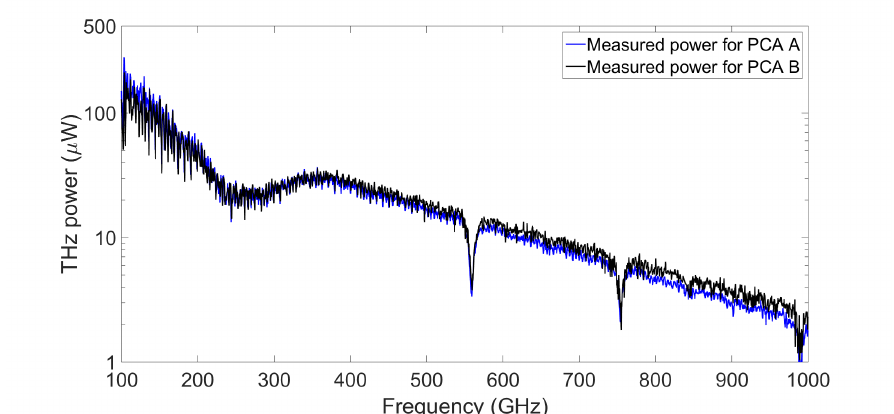
Figure A1. Measured THz powers emitted by the pin diode for the characterization of PCA A and